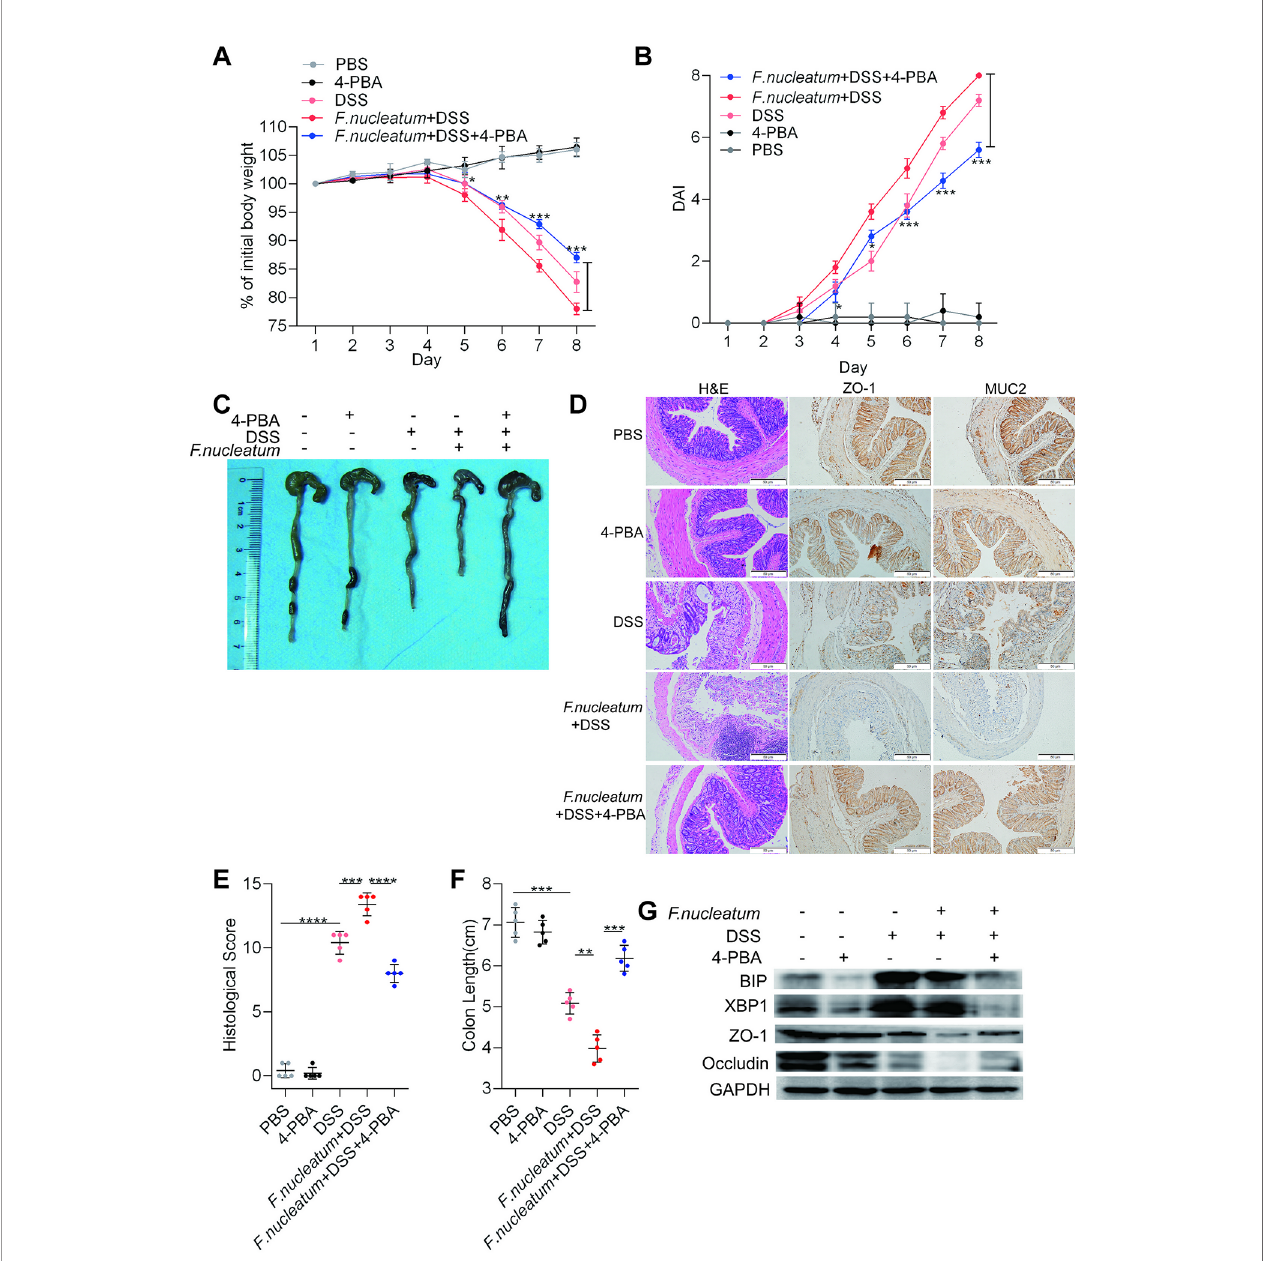
FIGURE 4 | Fusobacterium nucleatum facilitates intestinal mucosal barrier destruction through the endoplasmic reticulum (ER) pathway in dextran sulfate sodium (DSS)-induced mice. (A – F) Mice (n=5 per group) were given 4-phenyl butyric acid (4-PBA) (100 m g per mouse every 3 days) and treated with F. nucleatum or phosphate-buffered solution (PBS) for 2 weeks. Then, these mice were administered DSS along with continued 4-PBA treatment for an additional 7 days. Colitis induction was evaluated by body weight loss (A) and the disease activity index (DAI) (B) . (* P < 0.05, ** P < 0.01, and *** P < 0.001; one-way ANOVA combined with Bonferroni ’ s post hoc test; the error bars indicate the SDs). Representative colon morphology and length in the mice are shown in panel (C) and quanti fi ed in panel (F) . Representative images of histological analyses are shown in panel (D) and quanti fi ed in panel (E) (* P < 0.05, ** P < 0.01, *** P < 0.001, and **** P < 0.0001; unpaired Student ’ s t test; the error bars indicate the SDs; 200× magni fi cation). (G) Western blotting was performed to measure the levels of BIP, XBP1, ZO-1, and occludin in colon tissues from